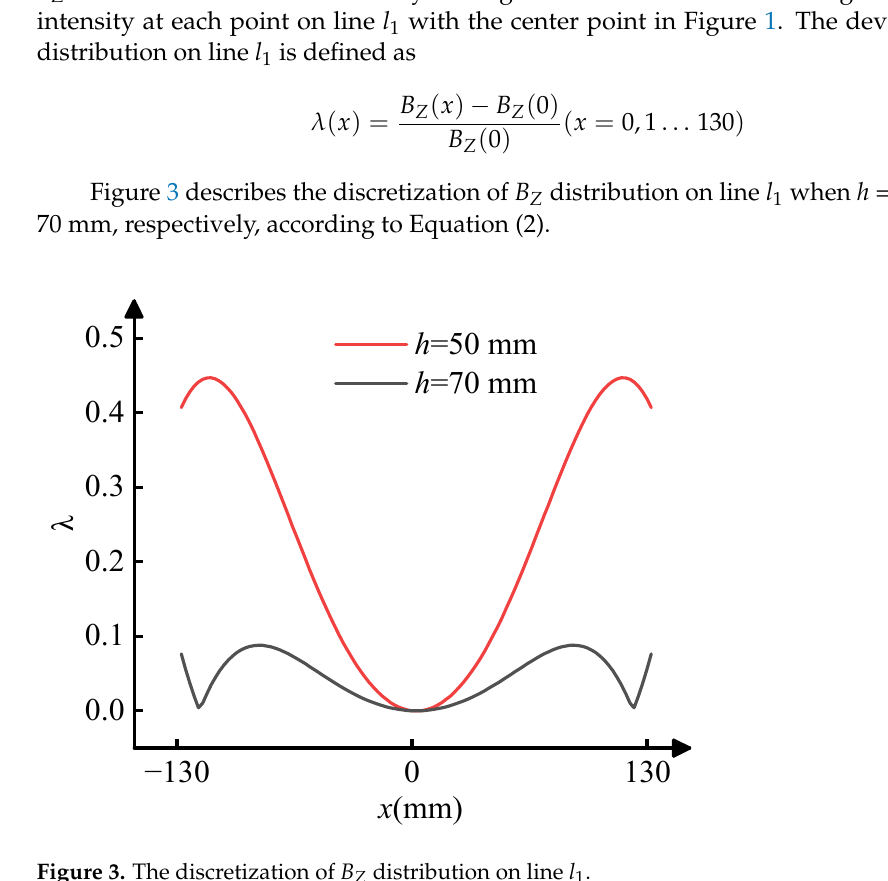
Figure 4. Influence of coil turn numbers N on B Z distribution . As can be seen from Figure 4, the distribution of B Z and the area of the UMF region at h = 70 mm is related to the turn numbers N of the circular coil. When N = 12, the distri- bution of B Z in the entire S -plane meets the conditions of a UMF; at the same time, the fluctuation of B Z is minimal. However, for h = 50 mm, as shown in Figure 4, by adjusting the turn numbers of the circular coil, the area of the UMF region S 1 always stays at a low